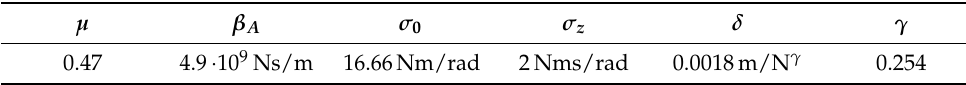
Figure 5. Results of the estimation of the slippage velocity after the estimation of parameters with a cardboard slider. Ground-truth robot velocity ω (blu), estimated velocity (cid:98) ω (red), estimation error (magenta). The inner plots are zooms that show details of the single repetitions; the zoomed areas are highlighted in the black boxes. Table 1. Model parameters estimated on a rigid cardboard